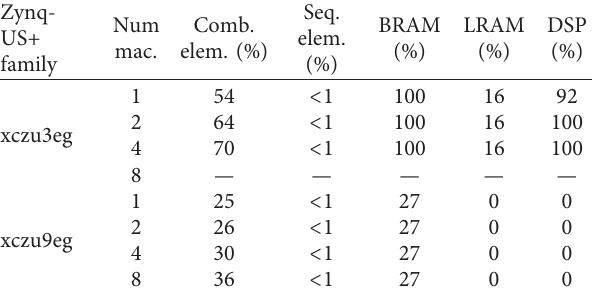
Table 9: Design portability analysis for Zynq-US+ family.